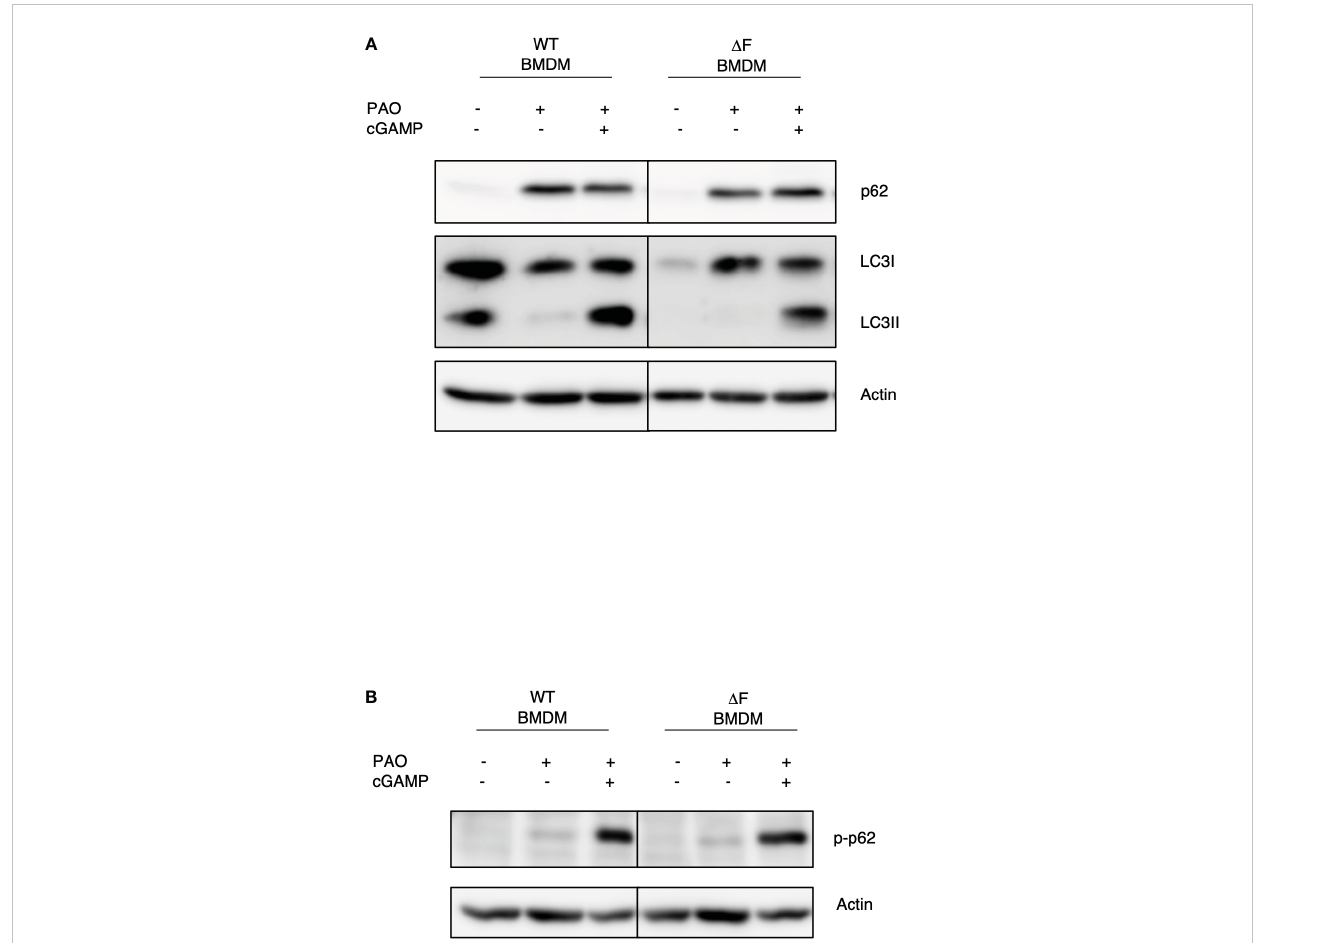
FIGURE 3 The re-establishment of the STING axis promotes autophagy in D F BMDMs (A) Western blot analysis of P62 and LC3I/II in PAO-1 infected WT and D F BMDMs, following 2h of 2 ’ ,3 ’ cGAMP stimulation. (B) Western blot analysis of p-P62 in PAO-1 infected